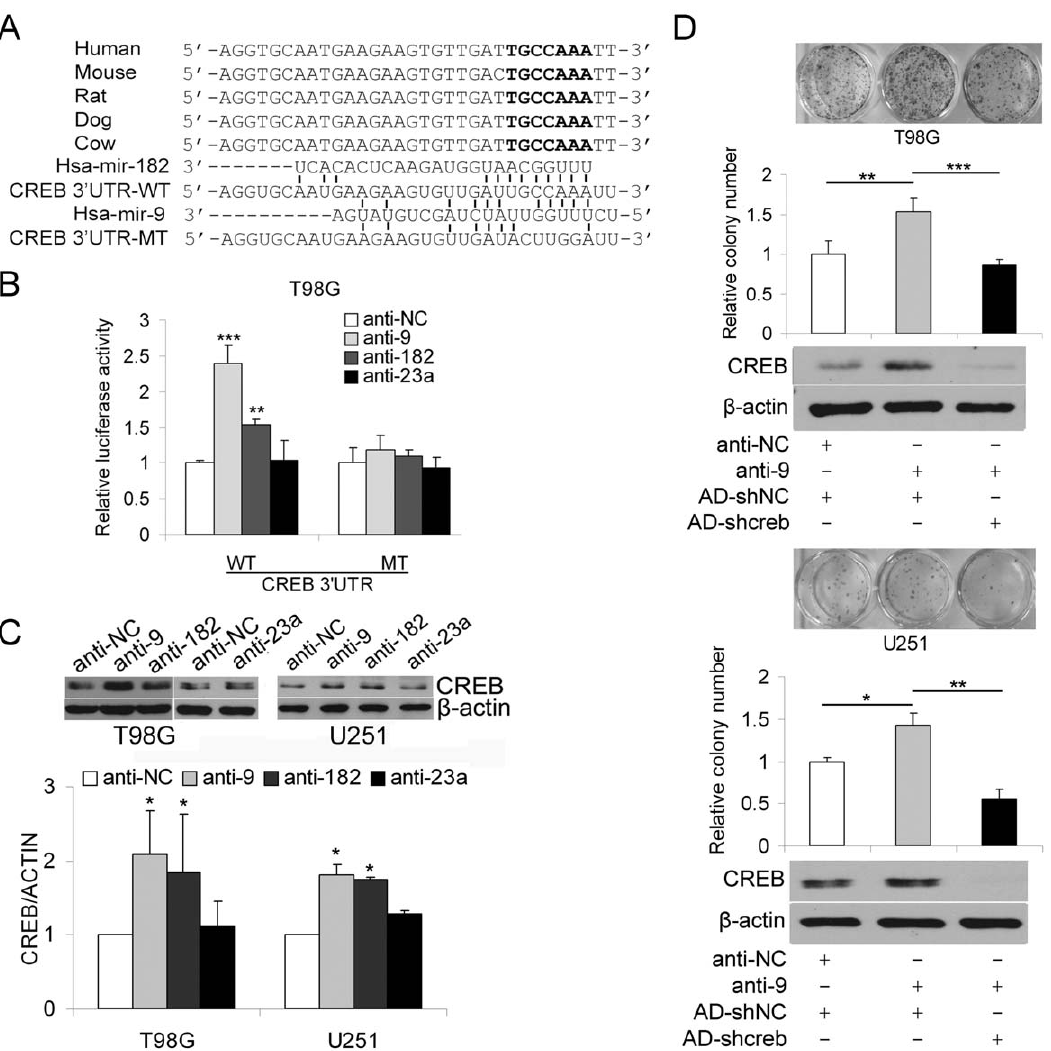
Figure 3. MiR-9 inhibits proliferation by targeting CREB. (A) MiR-9 and miR-182 share a binding site on the 3 9 UTR of CREB. A putative miR-182 binding site that is highly conserved among mammals was predicted by three algorithms (TargetScan, PicTar and MiRDB). A mutated CREB 3 9 UTR (CREB 3 9 UTR-MT) was generated by introducing mutations into the miR-182 binding site. (B) Luciferase reporter plasmids containing the wild-type (WT) or mutated (MT) CREB 3 9 UTR were co-transfected with synthetic miR-9, miR-182 or control miRNA mimics. After 24 h, the cells were harvested and the normalized luciferase activity was determined (mean 6 SD, n=4). (C) T98G cells were transfected with synthetic mimics of miR-9, miR-23a, miR-182 or control miRNA mimics. After 48 h, total cellular protein was extracted and the protein level of CREB was detected by western blotting (top). The western blotting results were quantified and plotted (mean 6 SD, n=3) (bottom). *, P , 0.05; **, P , 0.01, two-tailed unpaired Student’s t test. (D) T98G and U251 cells were transfected with miR-9 or control antagomirs followed by infection with AD-shcreb or AD-shNC. After 48 h, the transfected/infected cells were subjected to colony formation assay. The colonies were counted and plotted (mean 6 SD, n=4). On the top are representative photographs of the cell colonies, and the bottom depicts Western blotting results showing the CREB protein level of the transfected/ infected glioma cells. *, P , 0.05; **, P , 0.01; ***, P , 0.001, two-tailed unpaired Student’s t test.